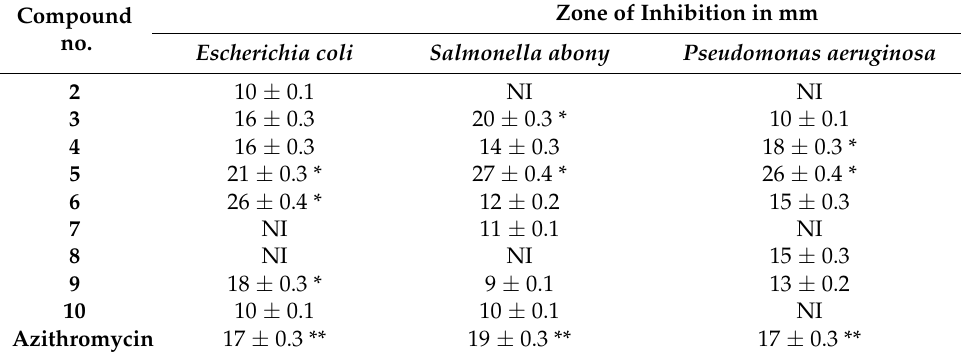
Table 2. Zone of inhibition observed against Gram-negative bacteria by the test analogs.